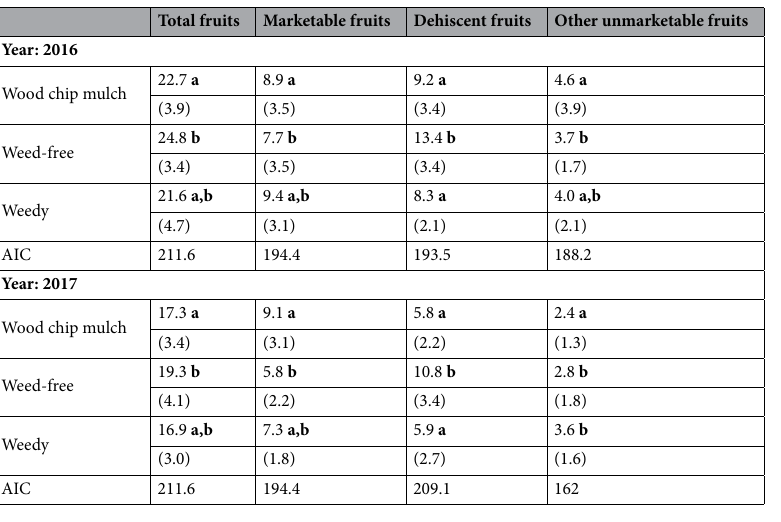
Table 2. Mean (1 SD) values of the number of tomato fruits per plant among three replicates in each treatment in 2016 and 2017. Other unmarketable fruits include fruits that too small fruits and pathogen- infected fruits (see Fig. 2). Different letters (a, b, c) in each fruit type show significant differences ( P < 0.05) among the treatments by generalized linear mixed models (GLMMs) including random effects among three